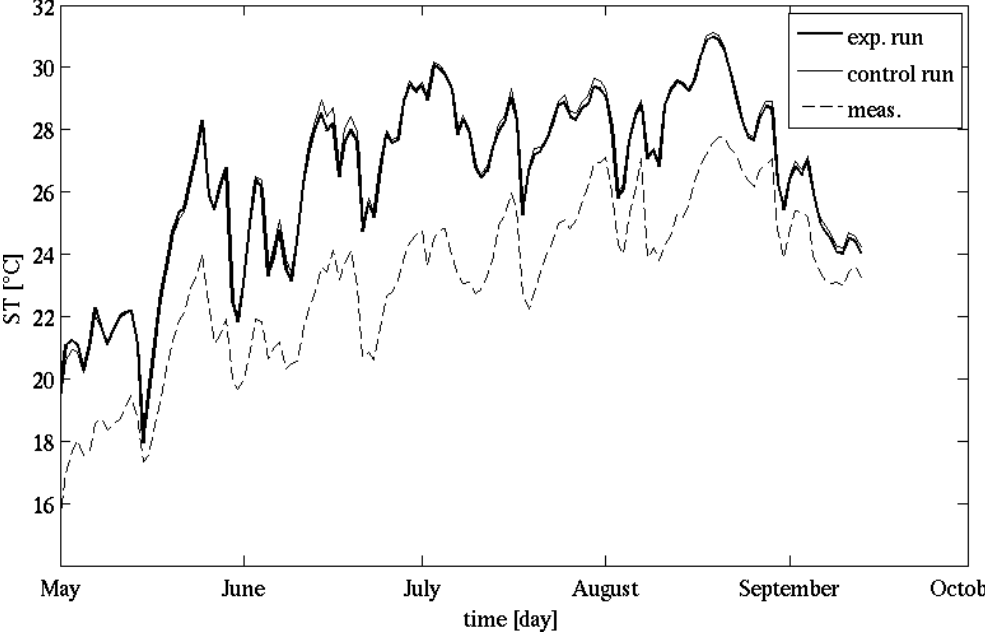
Figure 13. Mean daily value of soil temperature at 10 cm below the surface (in ◦ C) during the 2009 vegetative season. The dashed line shows the measurements while the thick line refers to the experimental run and the thin line to the control